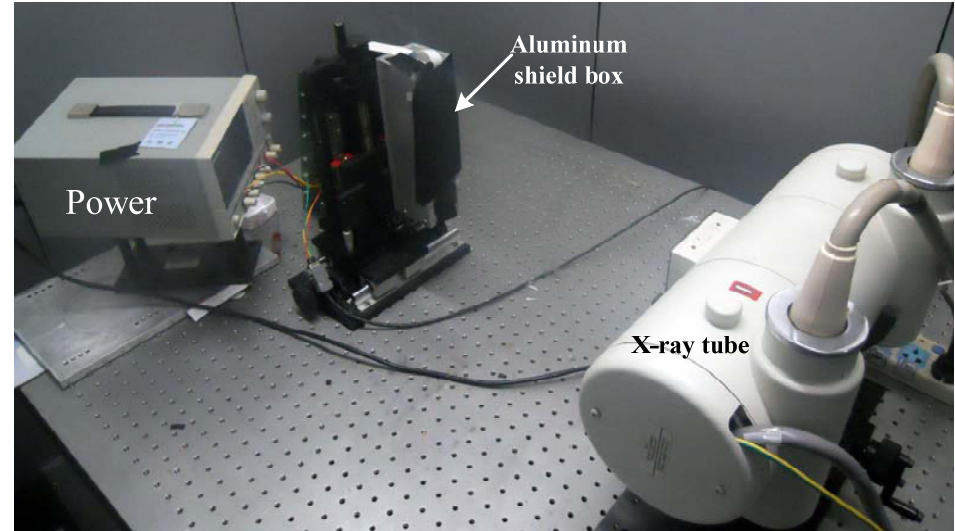
Figure 4. Photo of the modular detector